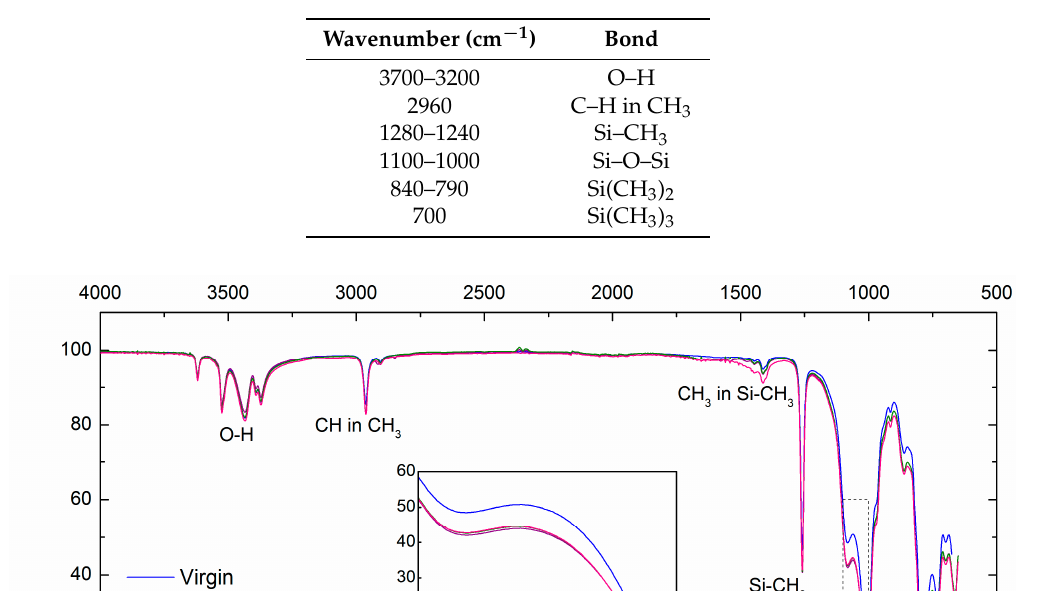
Table 1. Characteristic FTIR absorption bands for PDMS [29].